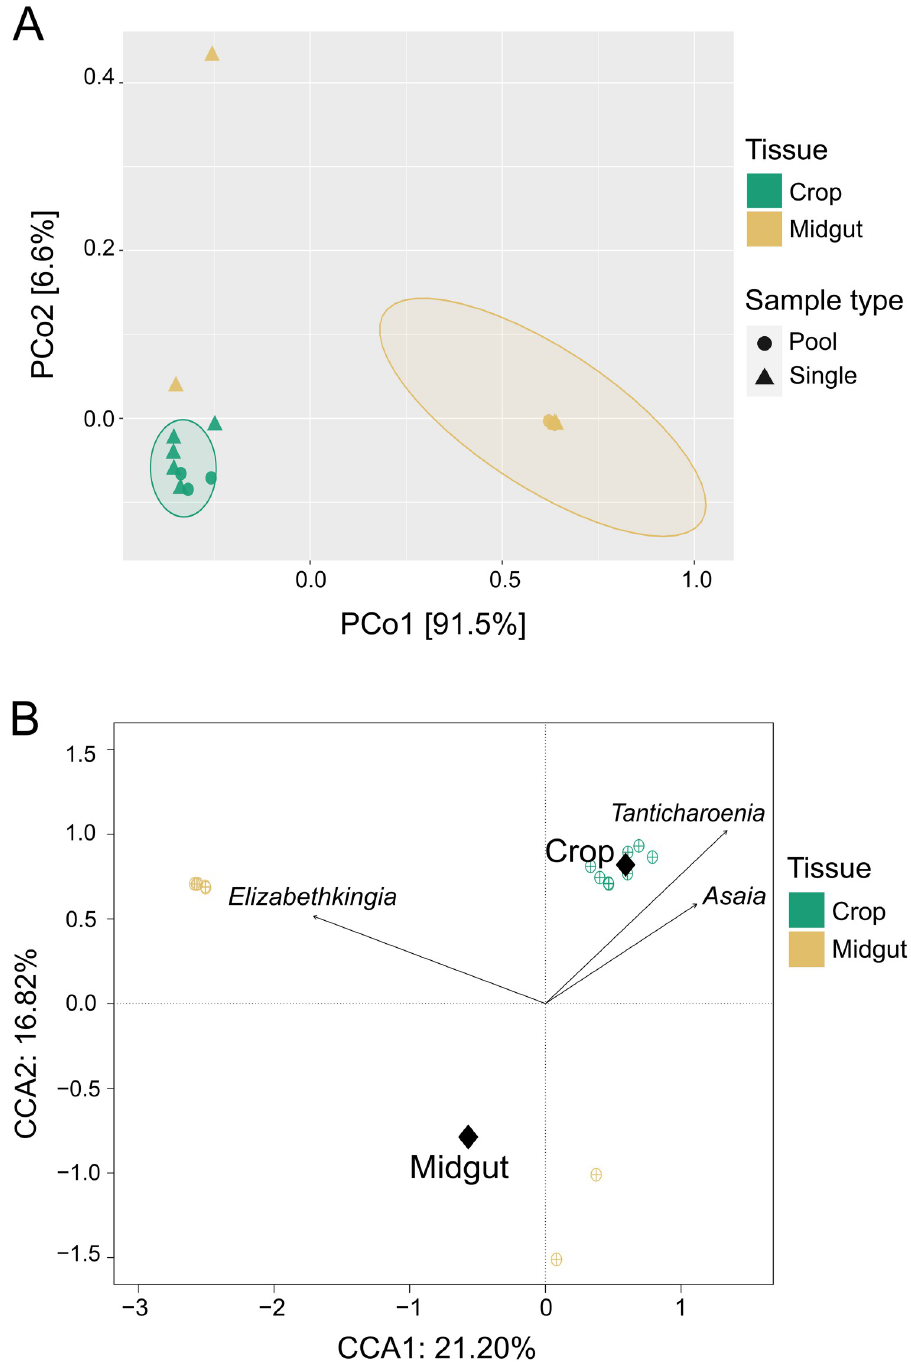
Fig 6. Ordination analyses reveal significantly different bacterial community structures between crop and midgut tissues. Beta diversity was estimated using Bray-Curtis dissimilarities. The unconstrained analysis (principal coordinates analysis, PCoA) (A) shows the samples cluster by tissue type predominately along axis 1 (91.7%). The constrained analysis (canonical correspondence analysis, CCA) (B) shows that the explanatory variables (Table 1) capture 21.2% and 16.82% of variation in CCA1 and CCA2, respectively. The group centroids of each tissue (represented by a black diamond) are located in opposing coordinates, indicating a difference between the communities. The abundance of the dominant taxa ( Asaia , Tanticharoenia , and Elizabethkingia ), shown as vector arrows, indicate that Asaia and Tanticharoenia are maximally abundant in crops while Elizabethkingia is maximally abundant in